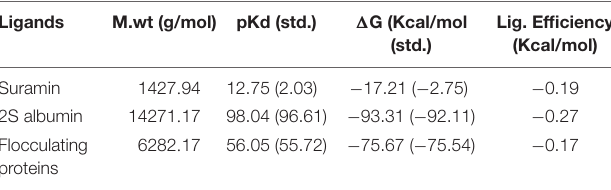
TABLE 1 | Output data from FireDock server. TABLE 3 | Binding affinity results from K DEEP : M.wt., Molecular weight; pKd, equilibrium dissociation constant (pKd, -log (Kd); (cid:49) G, Gibbs free energy. Ligands M.wt (g/mol) pKd (std.)